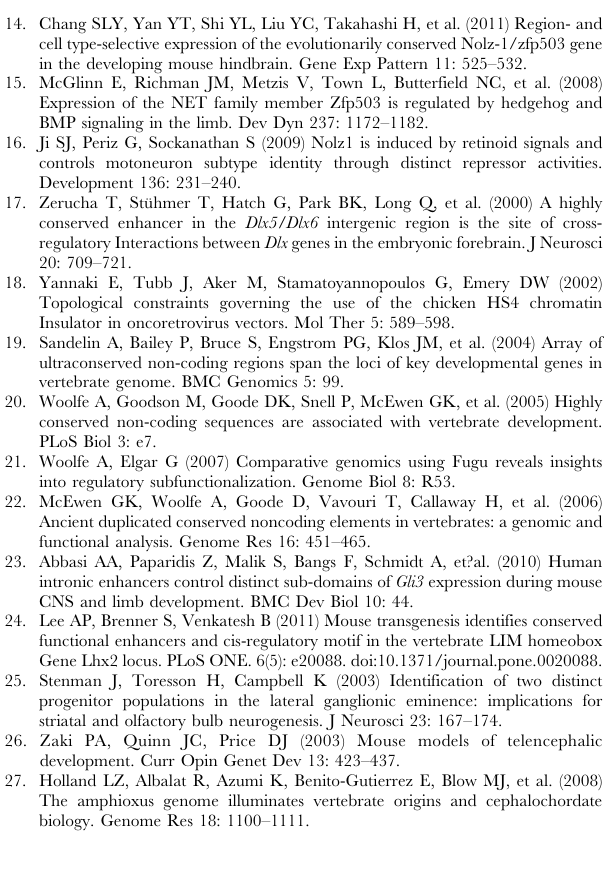
Figure S7 Whole mount X-gal staining of E11.5 frontal heads and E14.5 urogenital organs of UREB-LacZ